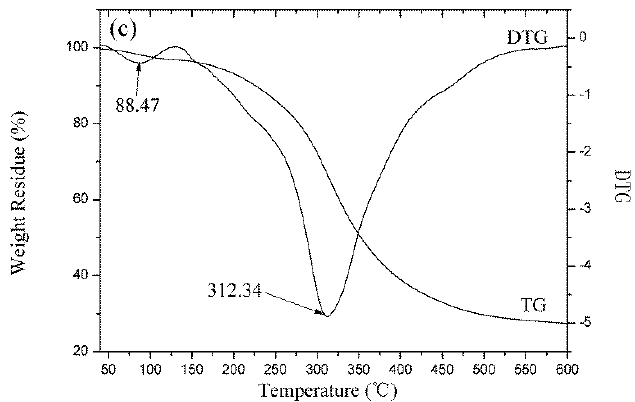
Figure 9. Thermogravimetric trace of ( a ) wool fibers; ( b ) KF; ( c ) GKF.